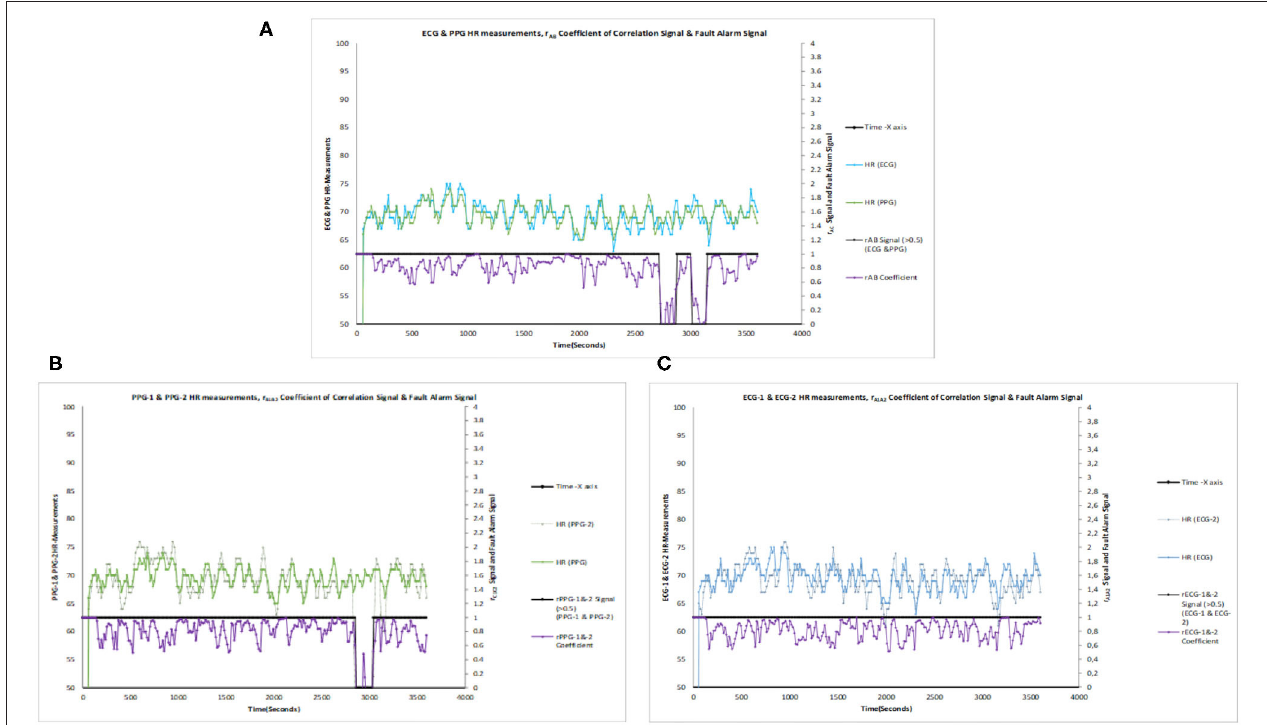
FIGURE 7 | (A) ECG and PPG HR measurements, r AB coefficient of correlation signal vs. fault alarm signal. (B) ECG-1 and ECG-2 HR measurements, r A1A2 coefficient of correlation signal vs. fault alarm signal. (C) PPG-1 and PPG-2 HR Measurements, r B1B2 coefficient of correlation signal vs. fault alarm signal.